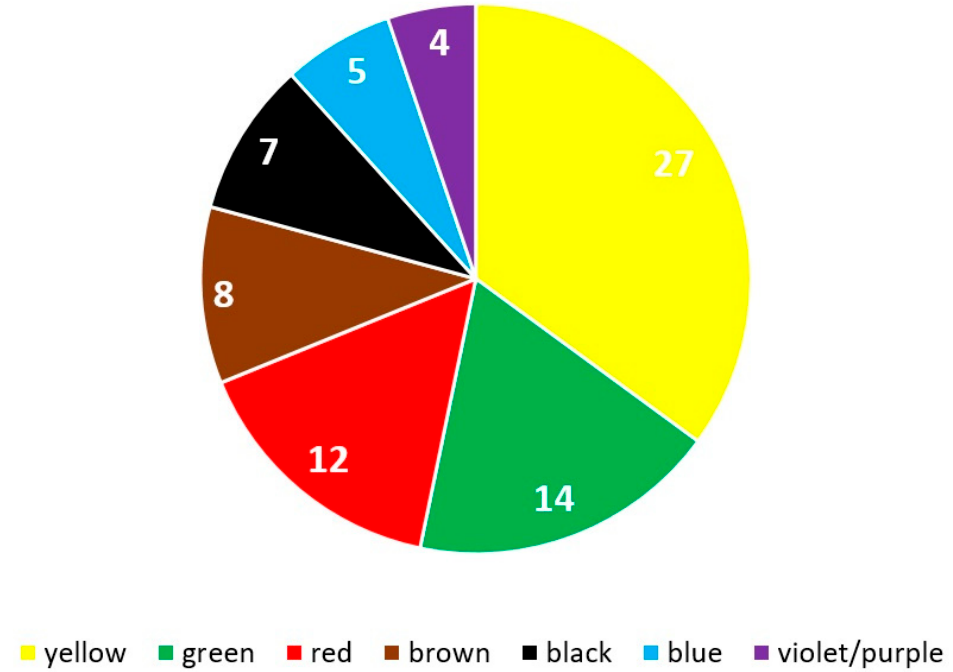
Figure 2. Number of species used for obtaining colors from plant dyes.